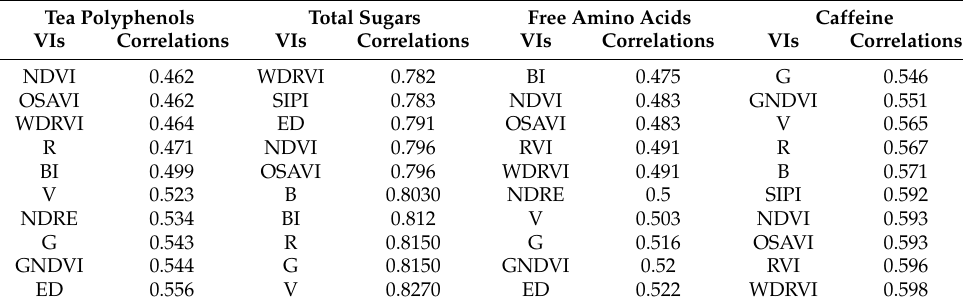
Table 3. Most relevant indices and their correlation coefficients.